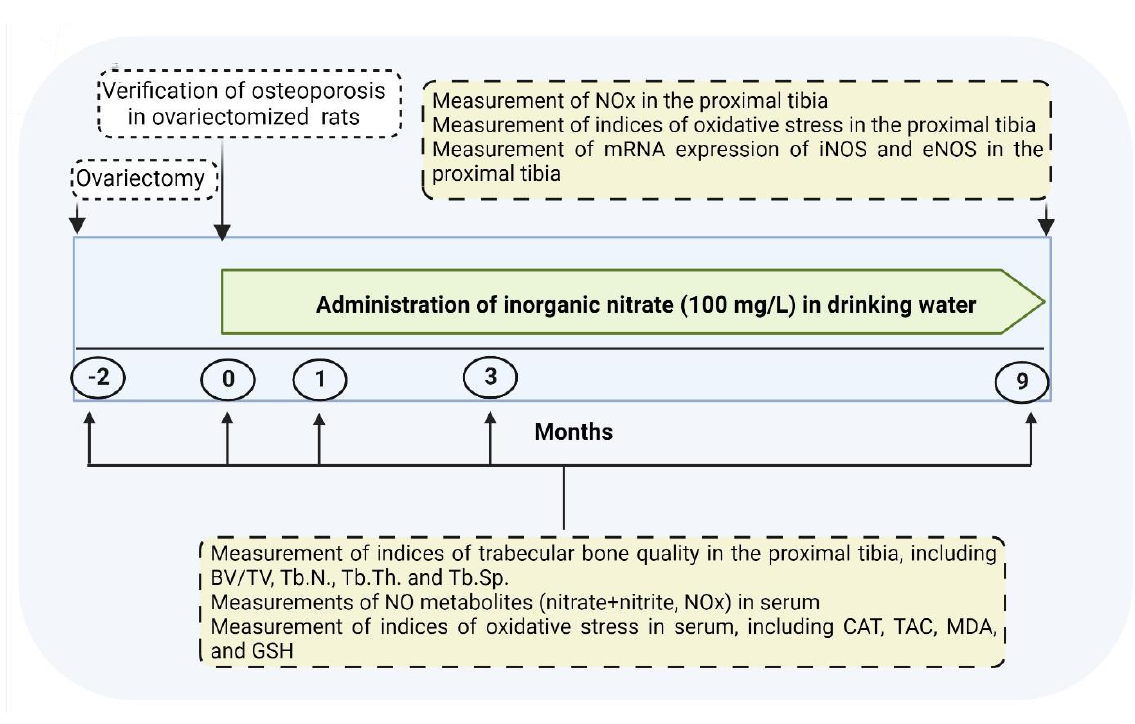
Figure 1: Experimental design of the study BV/TV, bone volume/tissue volume; CAT, catalase activity; eNOS, endothelial nitric oxide (NO) syn- thase; GSH, reduced glutathione; iNOS, inducible NOS; MDA, malondialdehyde; NOx, NO metabolites; TAC, total antioxidant capacity; Tb.N., trabecular number; Tb.Th., trabecular thickness; Tb.Sp., trabec- ular